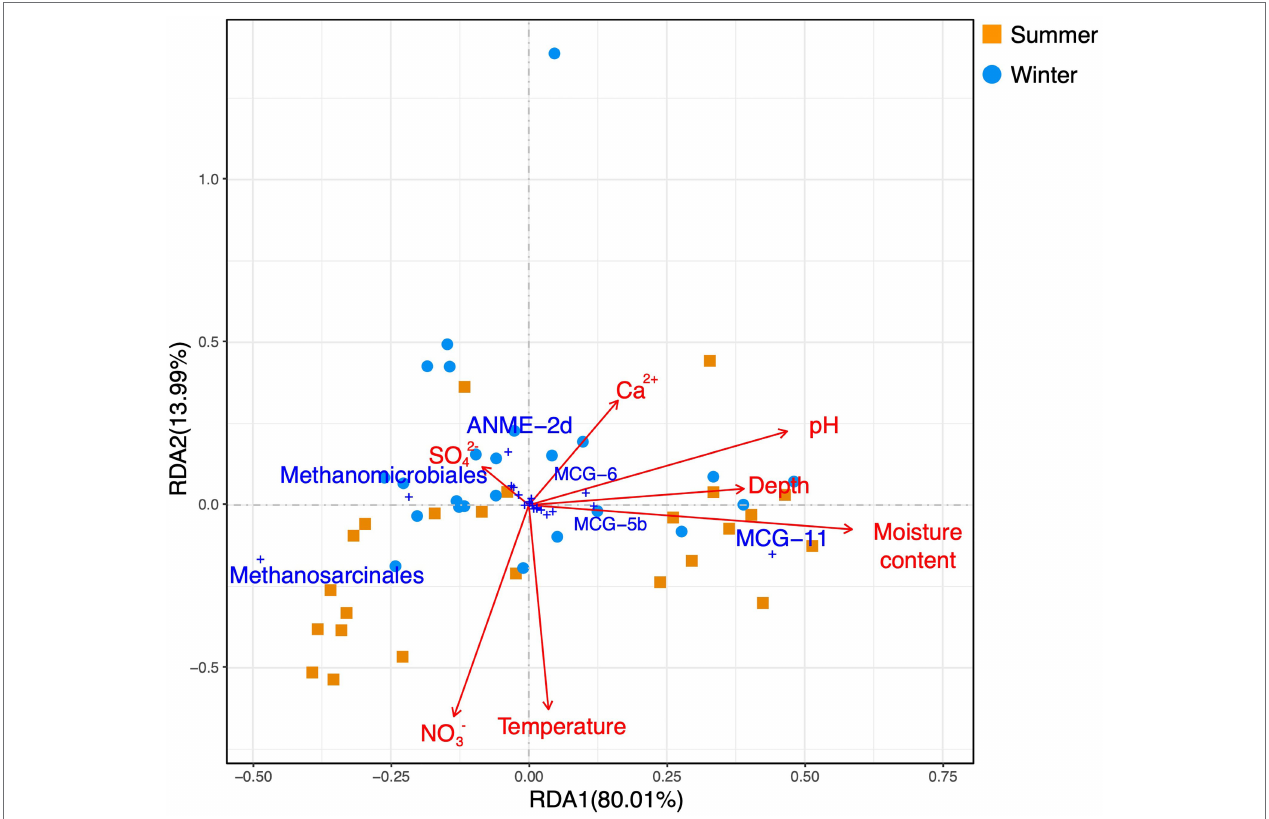
FIGURE 7 | A redundancy analysis based on environmental variables (pH, depth, moisture content, surface sediment temperature, and dissolved Ca 2+ , sulfate, and nitrate in the sediment pore water) fitted to proportions of euryarchaeotal orders and bathyarchaeotal